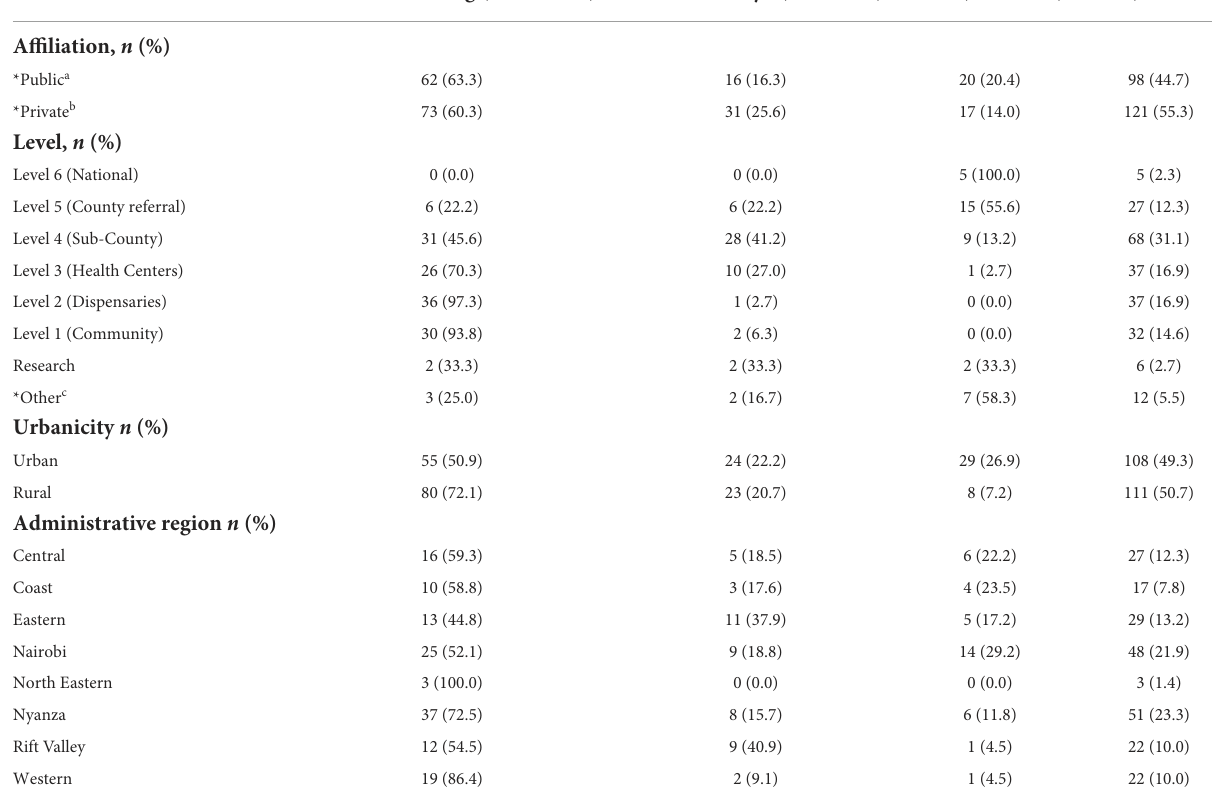
TABLE 1 Health facilities completing the survey by affiliation, level, and urbanicity in regions of Kenya, 2020.